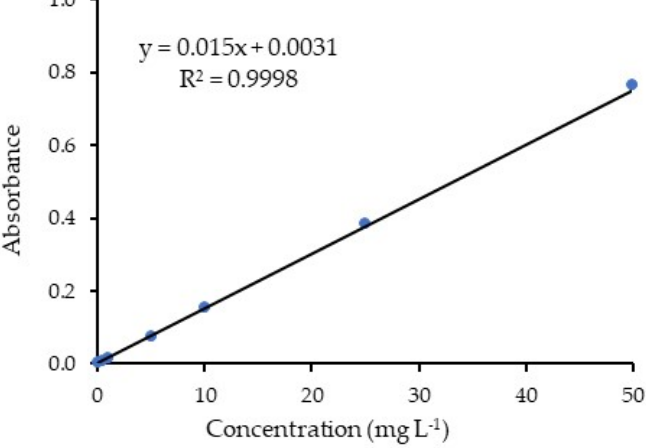
Figure 5. Calibration curve used to determine the tracer amount.